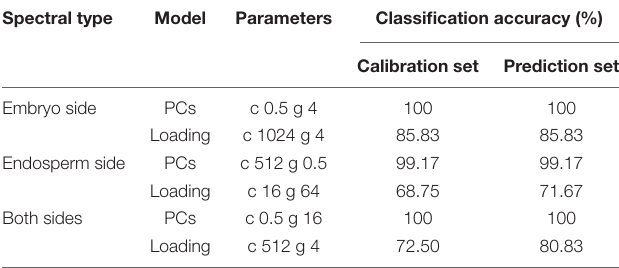
TABLE 3 | The classification results based on the first three PCs and the loading of PC3 using SVM algorithm.